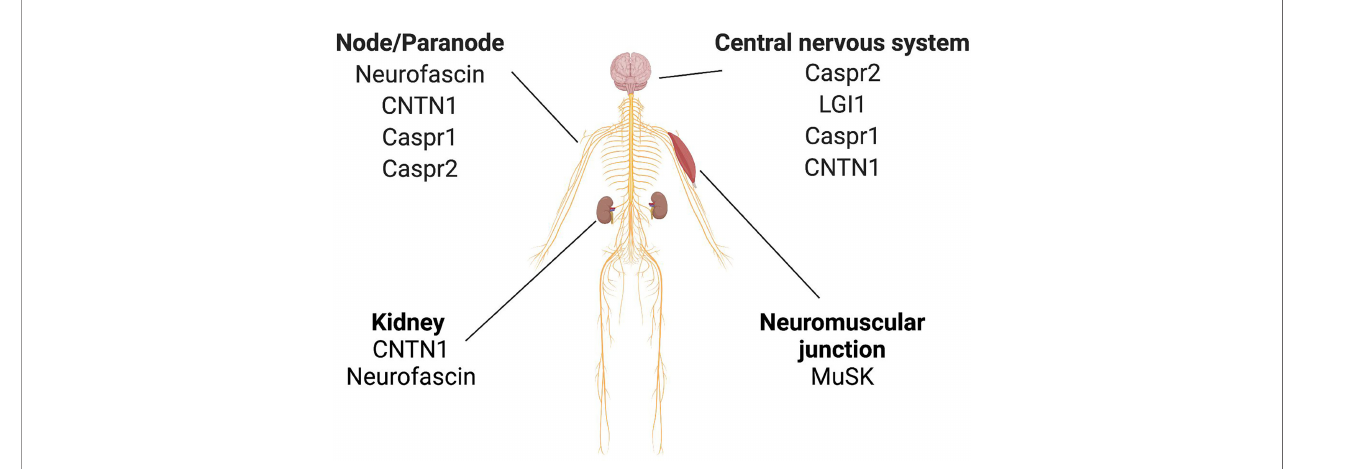
FIGURE 6 | Expression of selected neuronal/neuromuscular antigens that are targeted by pathogenic IgG4 autoantibodies (in a selection of relevant organs). Caspr1, contactin-associated protein-like 1; Caspr2, contactin-associated protein-like 2; CNTN1, contactin 1; LGI1, leucine-rich glioma inactivated protein- 1; MuSK, muscle-speci fifi c kinase.